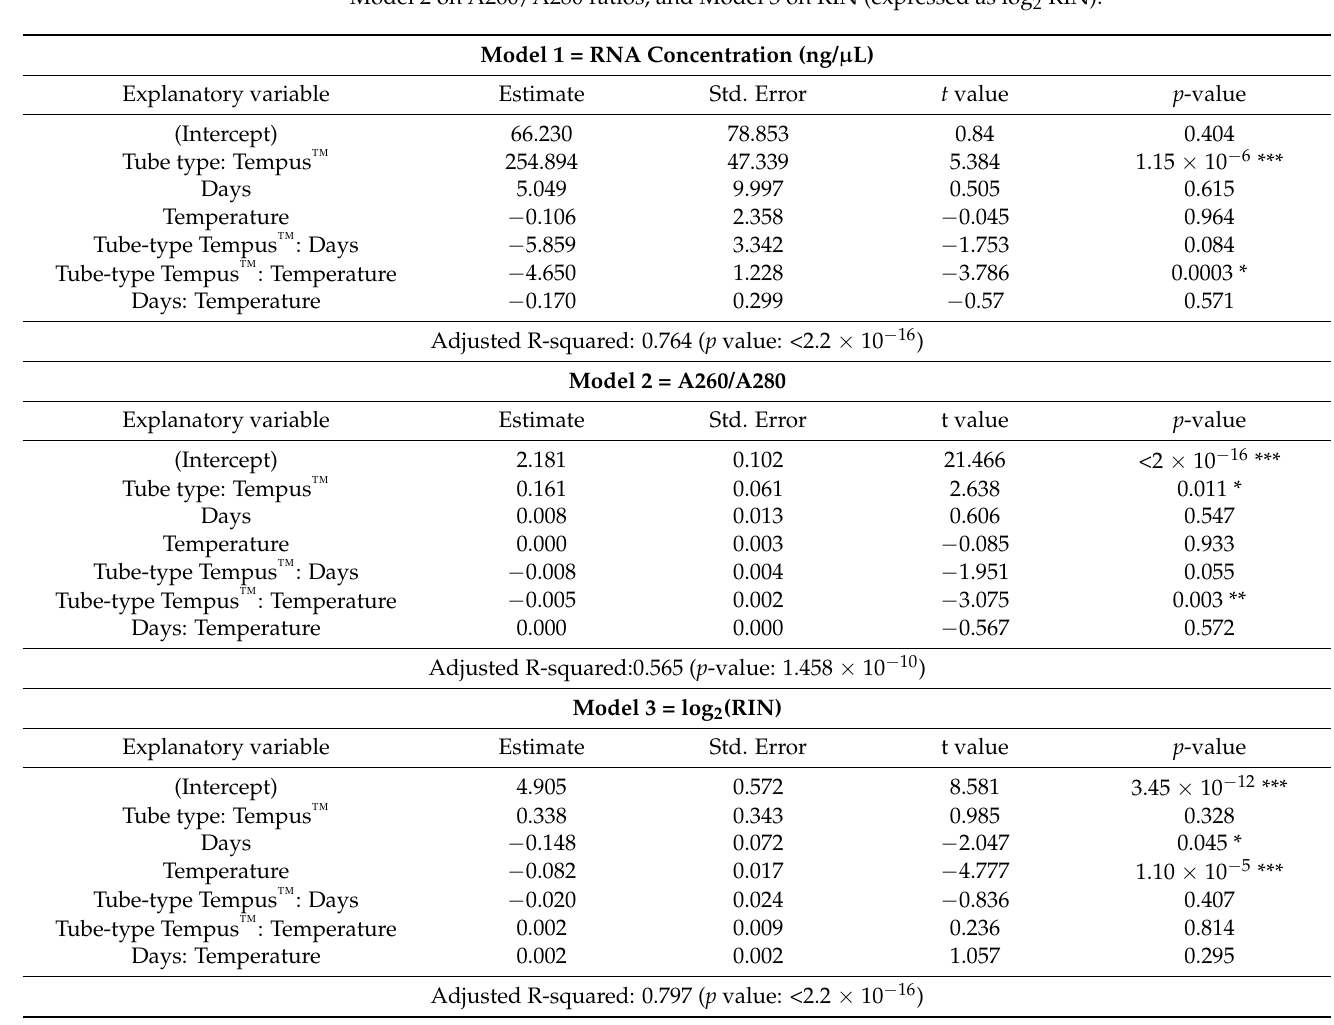
Table 1. Multiple linear regression models. Model 1 on normalized RNA concentration (ng/ µ